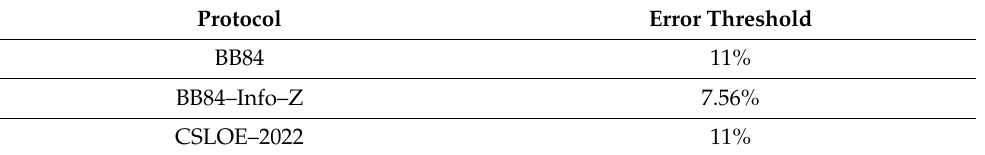
Figure 6. The threshold of errors for the modification CSLOE – 2022 proposed by the authors. Table 2. Comparative characteristics of protocols by threshold of